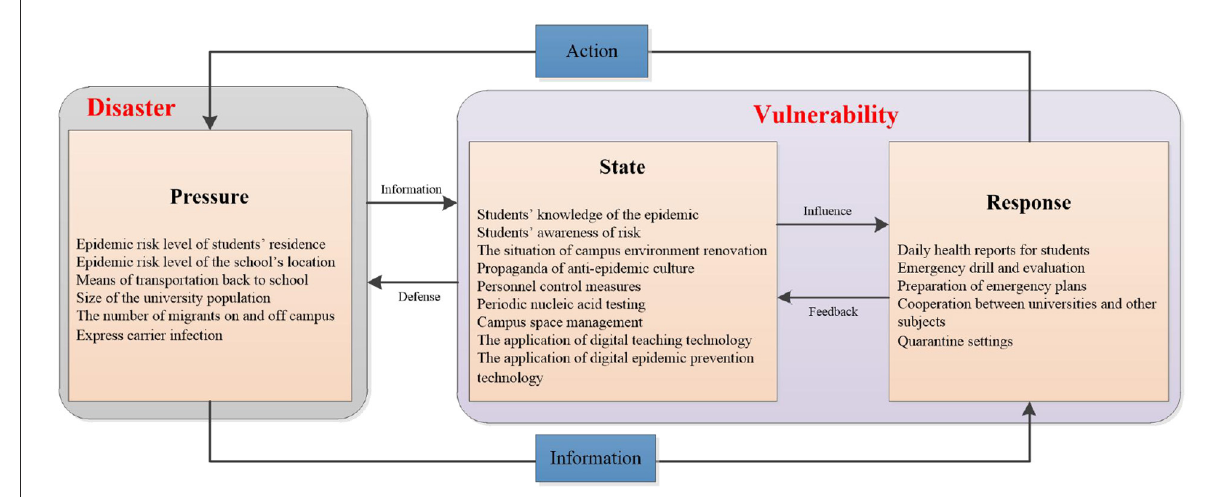
FIGURE1 PSR mechanism model of epidemic risk situation in universities from a disaster management perspective.